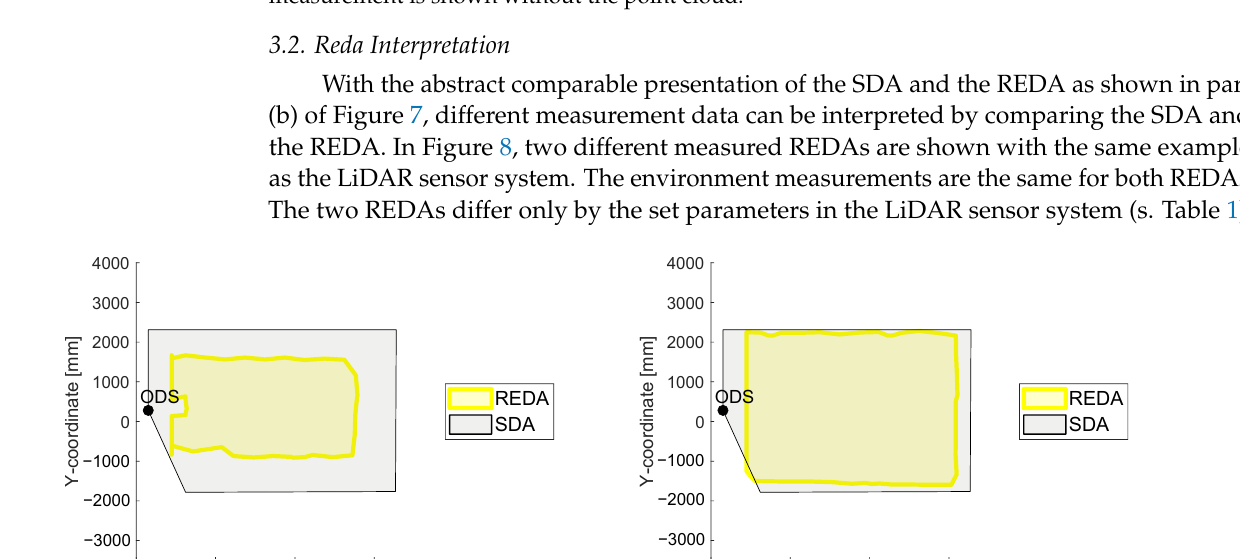
Figure 7. In part ( a ) the visualization of the same data from Figure 5 is shown. In part ( b ), the same measurement is shown without the point cloud.